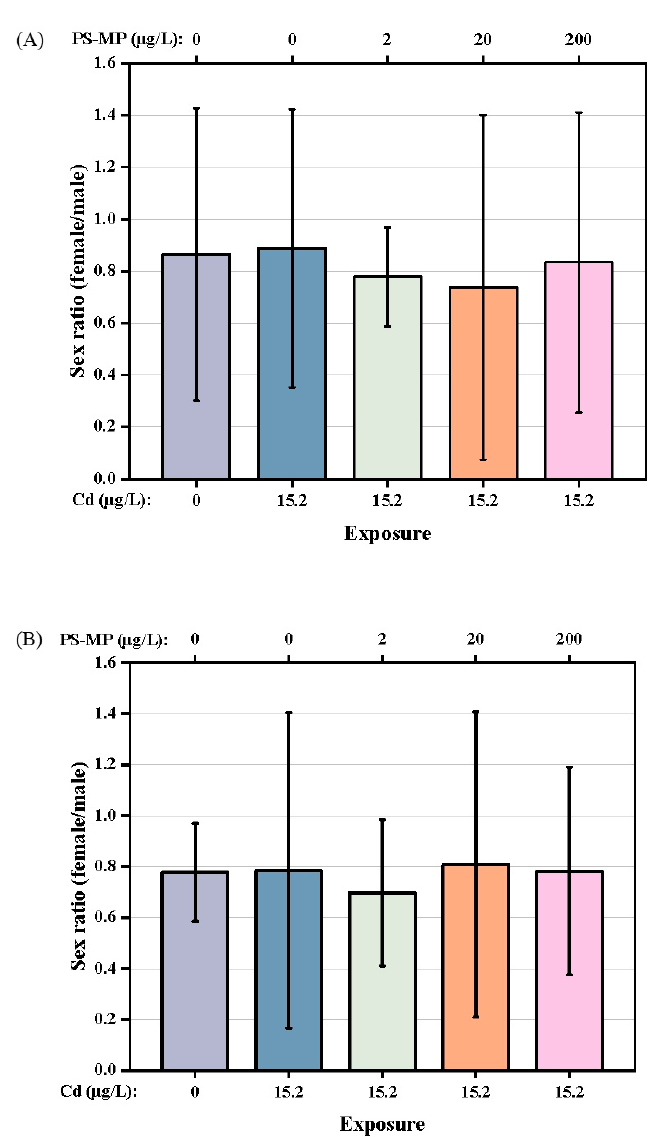
Figure 5. Sex ratio of T. japonicas exposure to Cd and PS-microplastic. ( A ): F1 generation, and ( B ): F2 generation.